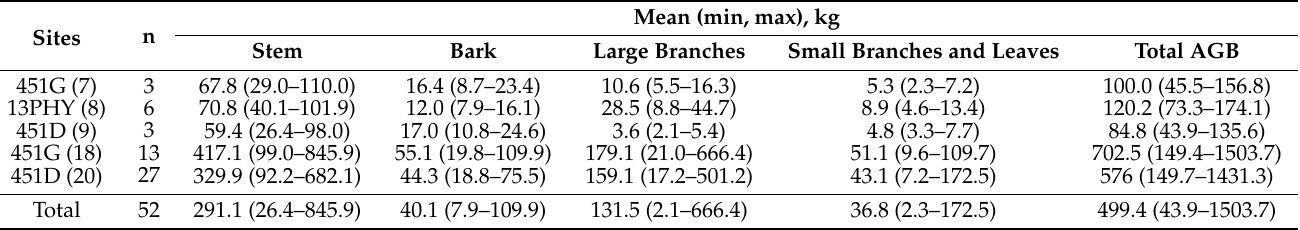
Table 3. Biomass of each tree component, including stem (under bark), stem bark, large branches ( ≥ 2 cm diameter), small branches (<2 cm diameter) and leaves sampled at three sites (451D, 451G, and 13PHY). For each component mean, minimum and maximum values are